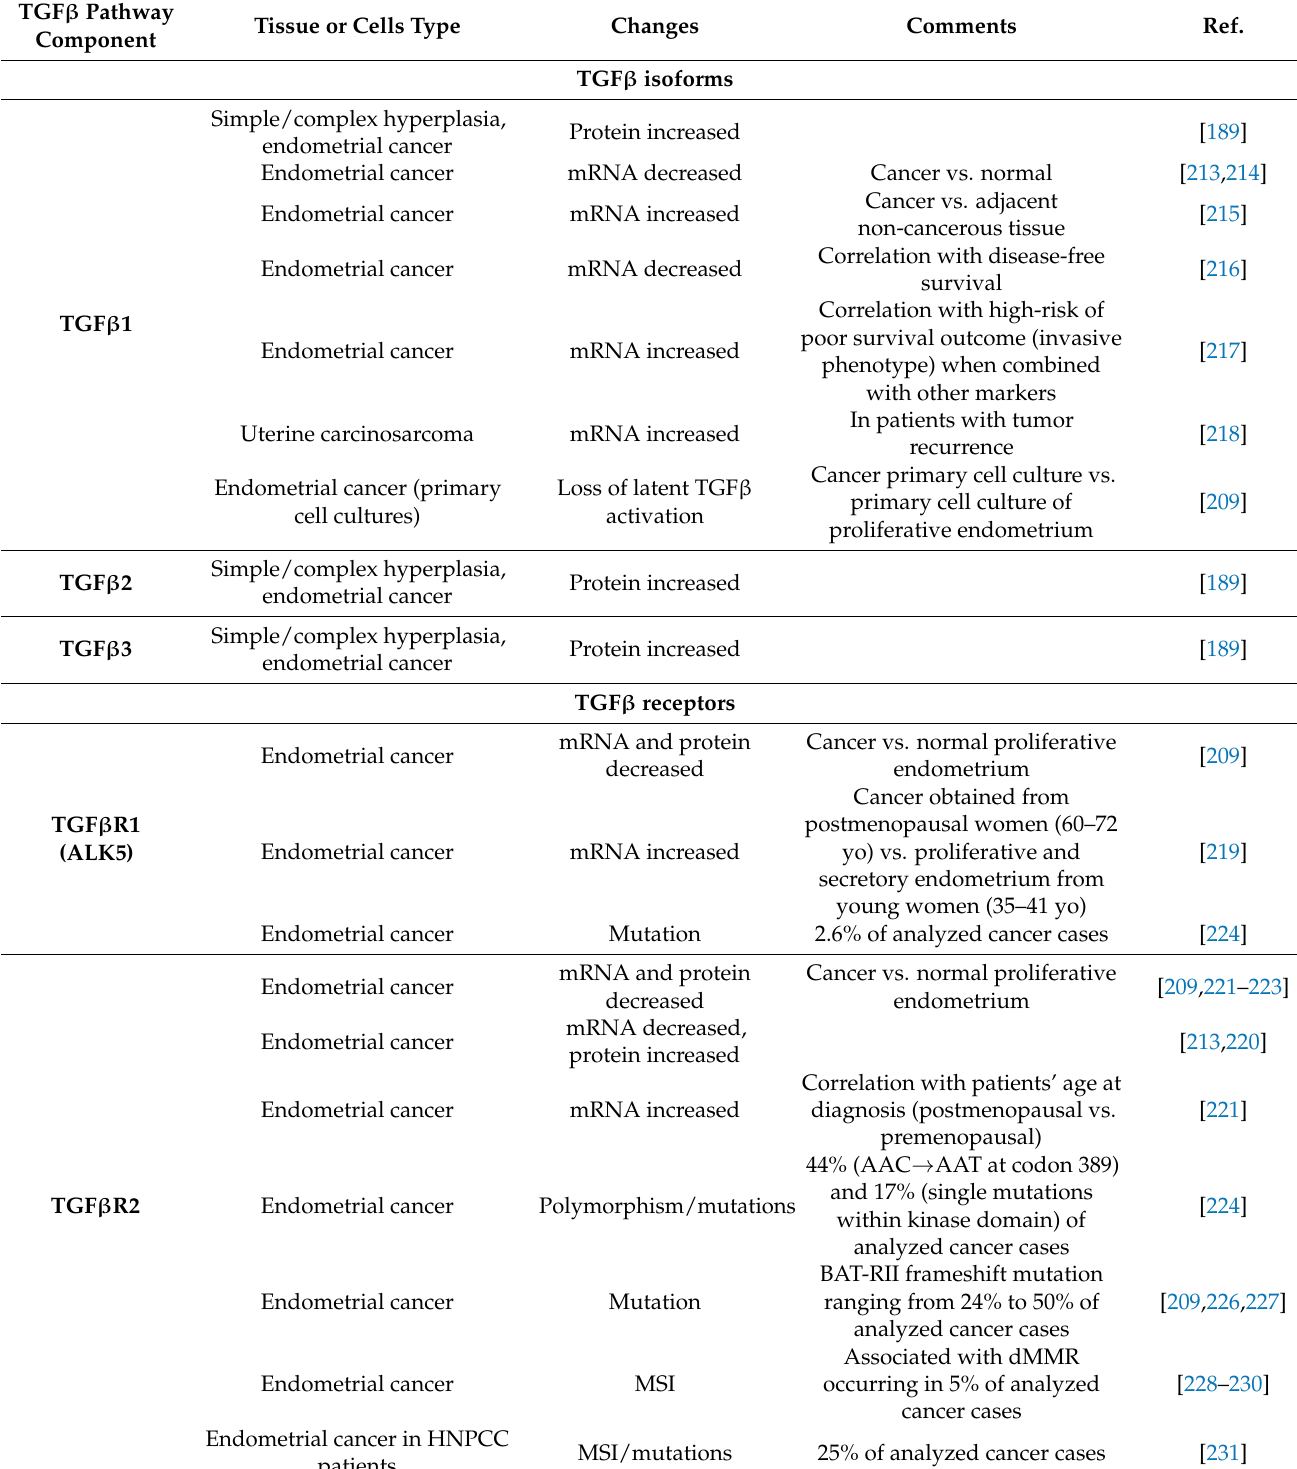
Table 1. Altered canonical TGFB signaling components in endometrial